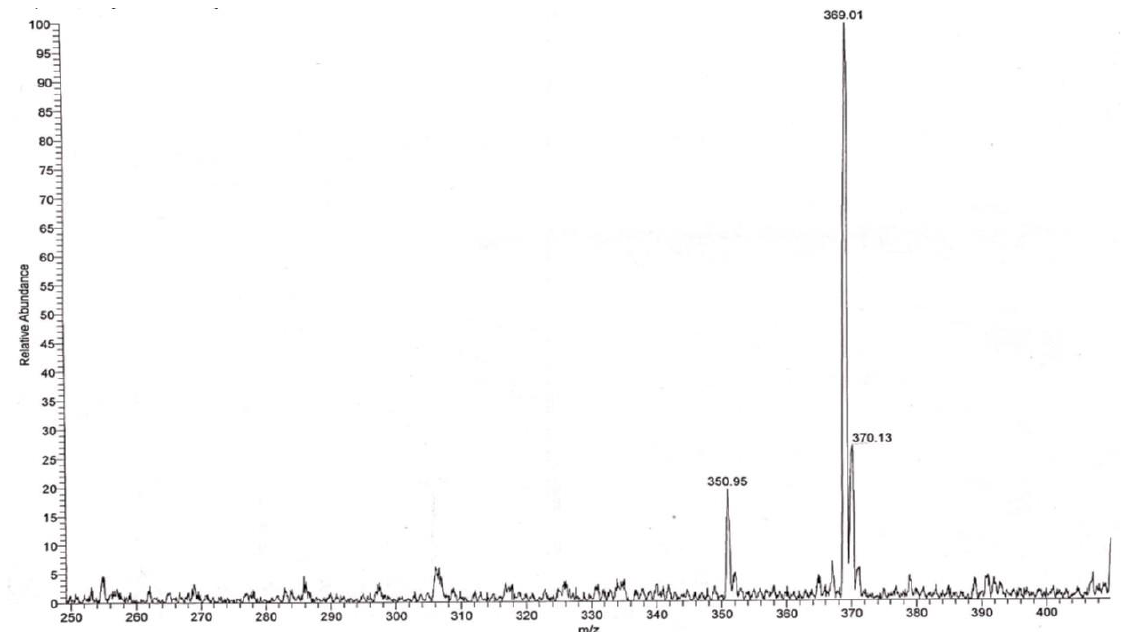
Figure 2. Mass spectrum analysis of compound 2. After collecting compound 2 (retention time 25–26 min in HPLC), sample was evaporated, the product was dissolved in 0.3 mL methyl alcohol, and 5 µ L was subjected to mass spectrum analysis. The electron spray mass spectrum was obtained with a TSQ Quantum Access mass spectrometer (Thermo Fisher Scientific, Basel, Switzerland).